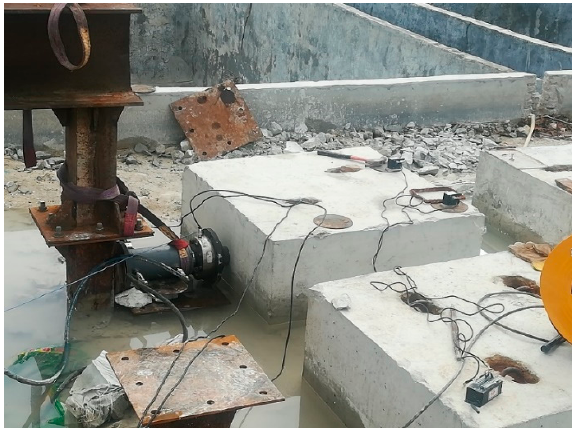
Figure 10. Horizontal jack loading of Hp specimen.